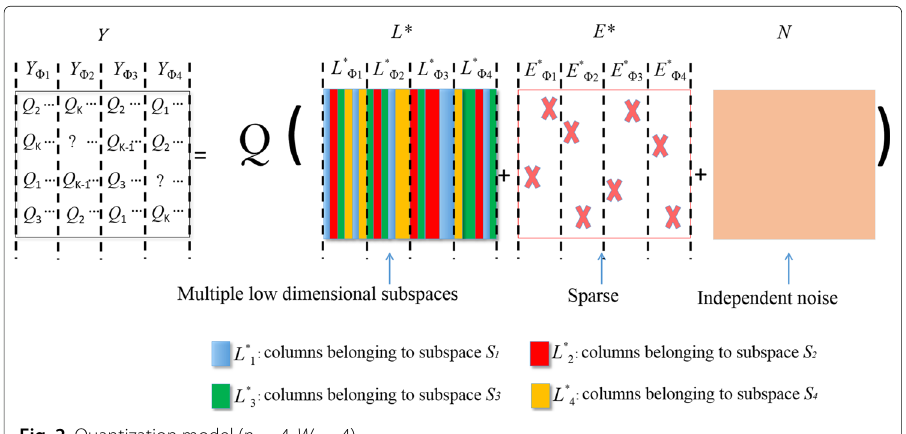
Fig. 2 Quantization model ( p = 4, W =